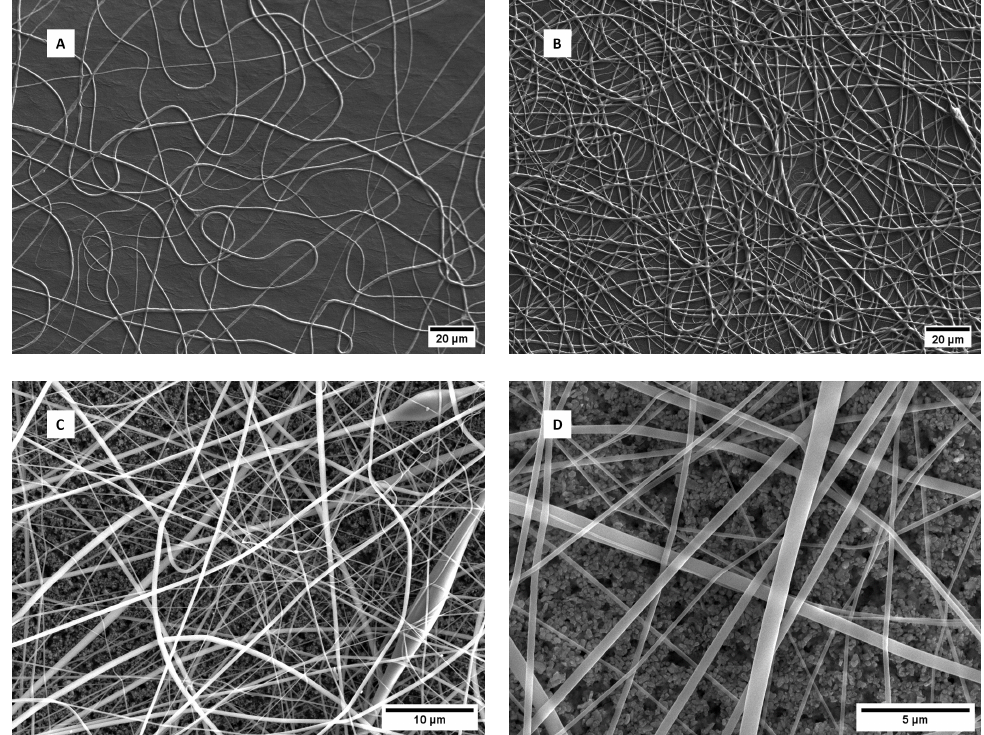
Figure 2. SEM pictures of spinning fibers on separators: ( A ) Polymer B on a PE separator after 1 min (123 mg/m 2 ) and ( B ) after 4 min (491 mg/m 2 ) of electrospinning. ( C , D ) Polymer A on ceramic separator after 2 min of electrospinning (both 467 mg/m 2